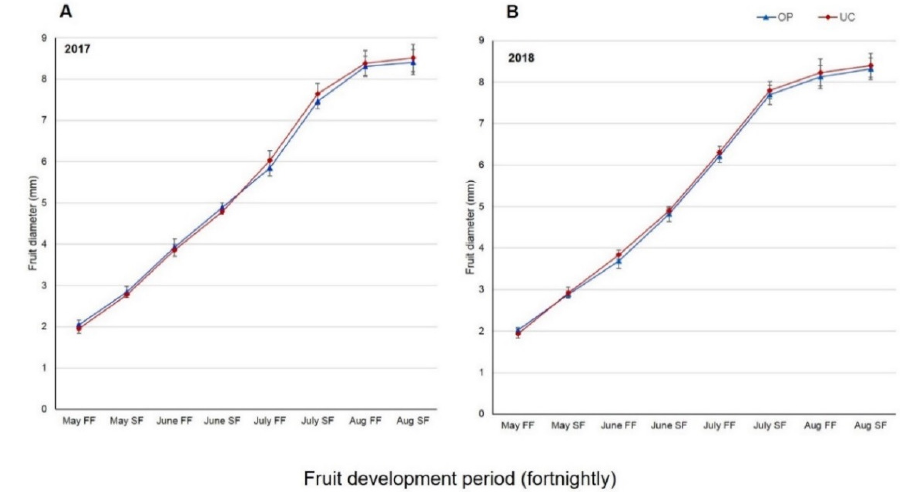
Figure 4. Fortnightly fruit diameter growth of P. crenulata at two sites (OP and UC) during 2017 (A) and 2018 (B). Independent (between sites) and paired (between years) t -test were performed and there were no significant differences (P<0.05) between the sites, as well as between the years (OP – open pasture; UC – under canopy; FF – first fortnight; SF – second fortnight). Vertical bars indicate